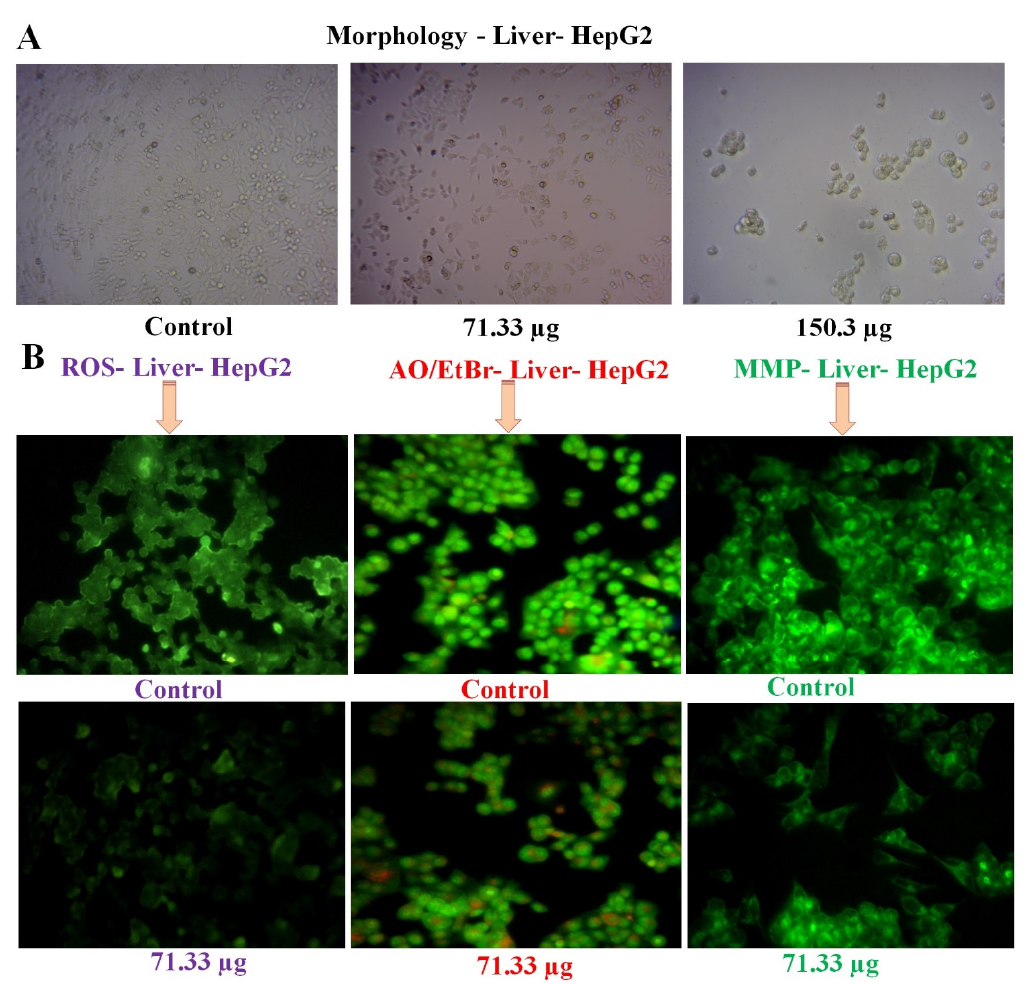
Figure 10. ( A ) Morphology–Liver–Hep G2 fucoidan from S. ilicifolium and ( B ) ROS, Ao/EtBr –Liver –Hep G2 fucoidan from S.